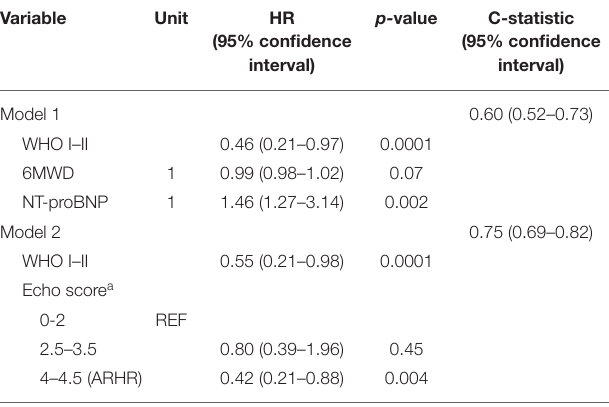
TABLE 3 | Cox regression models for dead prediction at the first follow-up evaluation: model 1 and model 2. Variable